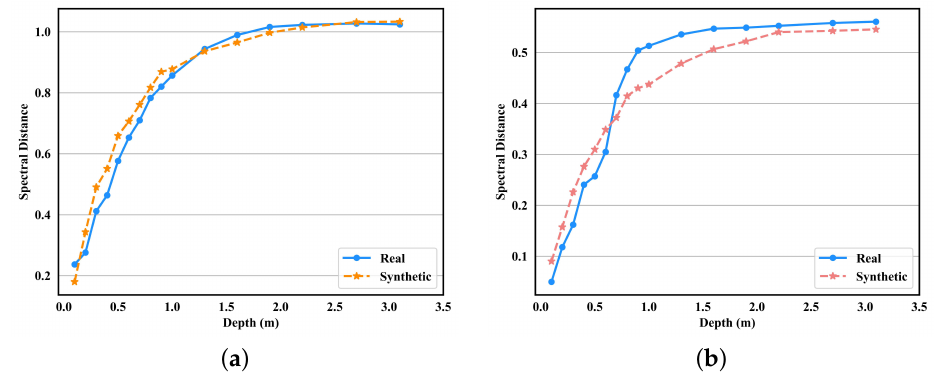
Figure 9. The spectral distance of iron and stone on synthetic data and real data. ( a ) Iron. ( b ) Stone.